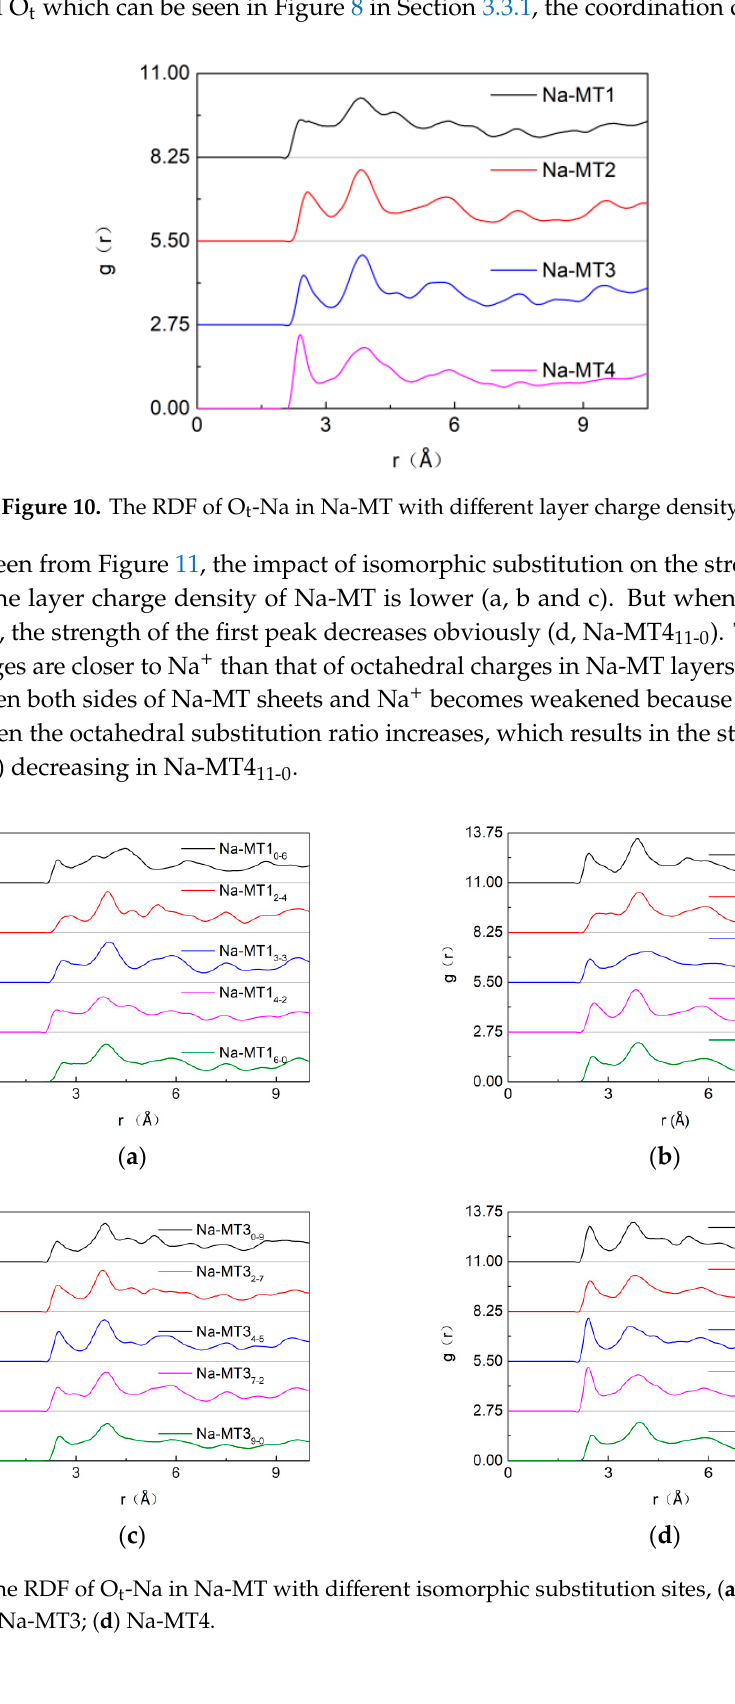
Figure 11. The RDF of O t -Na in Na-MT with different isomorphic substitution sites, ( a ) Na-MT1; ( b ) Na-MT2; ( c ) Na-MT3; ( d ) Na-MT4.